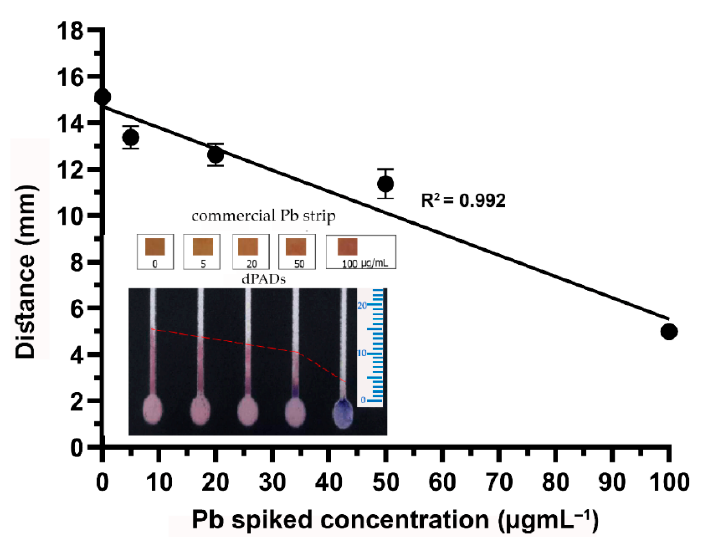
Figure 5. Drinking water with Pb (0–100 µg·mL − 1 ) tested with commercial strips and the dPAD using 0.4 mmol·L − 1 CA ( n = 3).